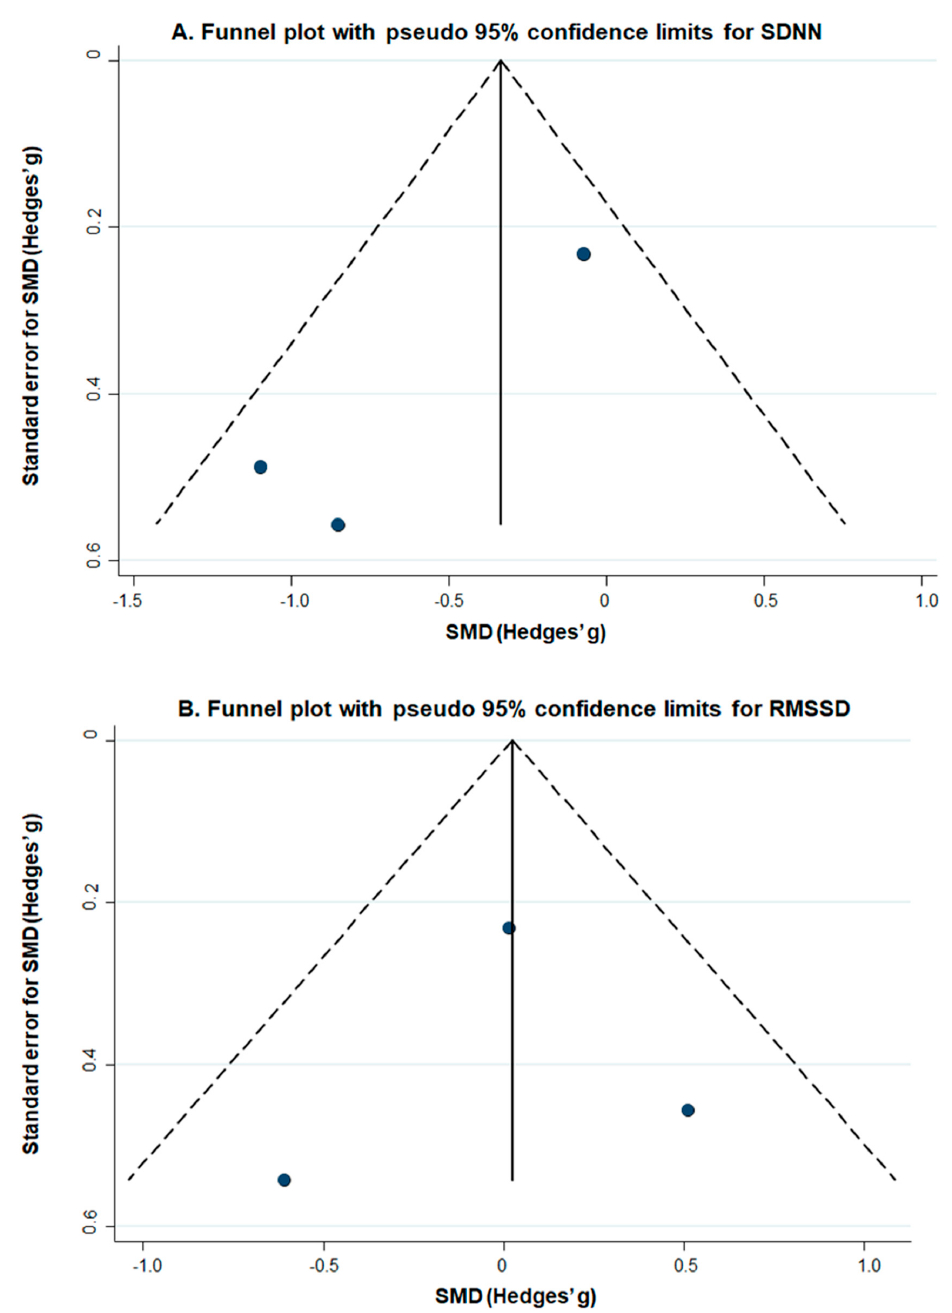
Figure A3. Funnel plots of standard error for Hedges’ g effect sizes for time domain heart rate variability parameters: ( A ) standard deviations of normal-to-normal R-R intervals (SDNN), and ( B ) root mean square standard deviations of R-R intervals (RMSSD).